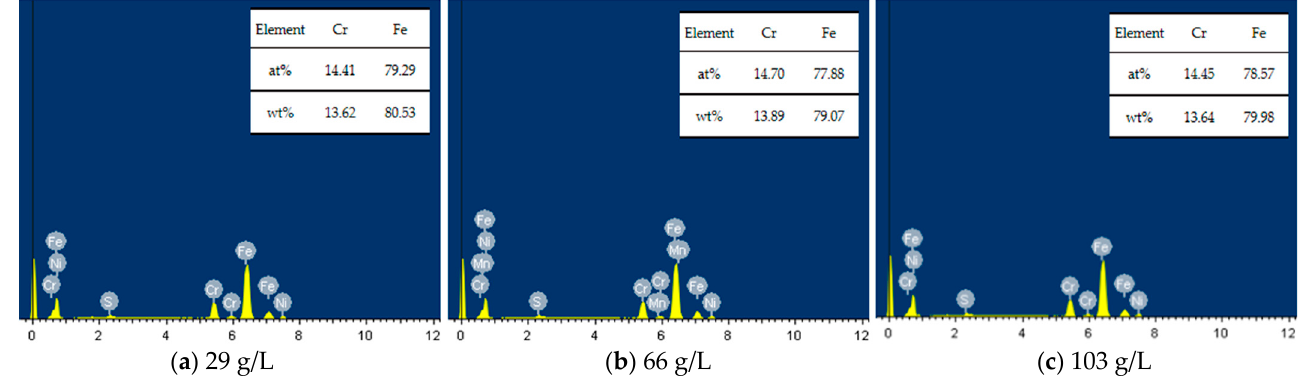
Figure 6. The EDS spectra of samples at different acid concentrations: ( a ) 29 g/L; ( b ) 66 g/L; and ( c ) 103 g/L. The result of sample soaked in solution with acid concentration of 48 g/L is shown in Figure 5b.